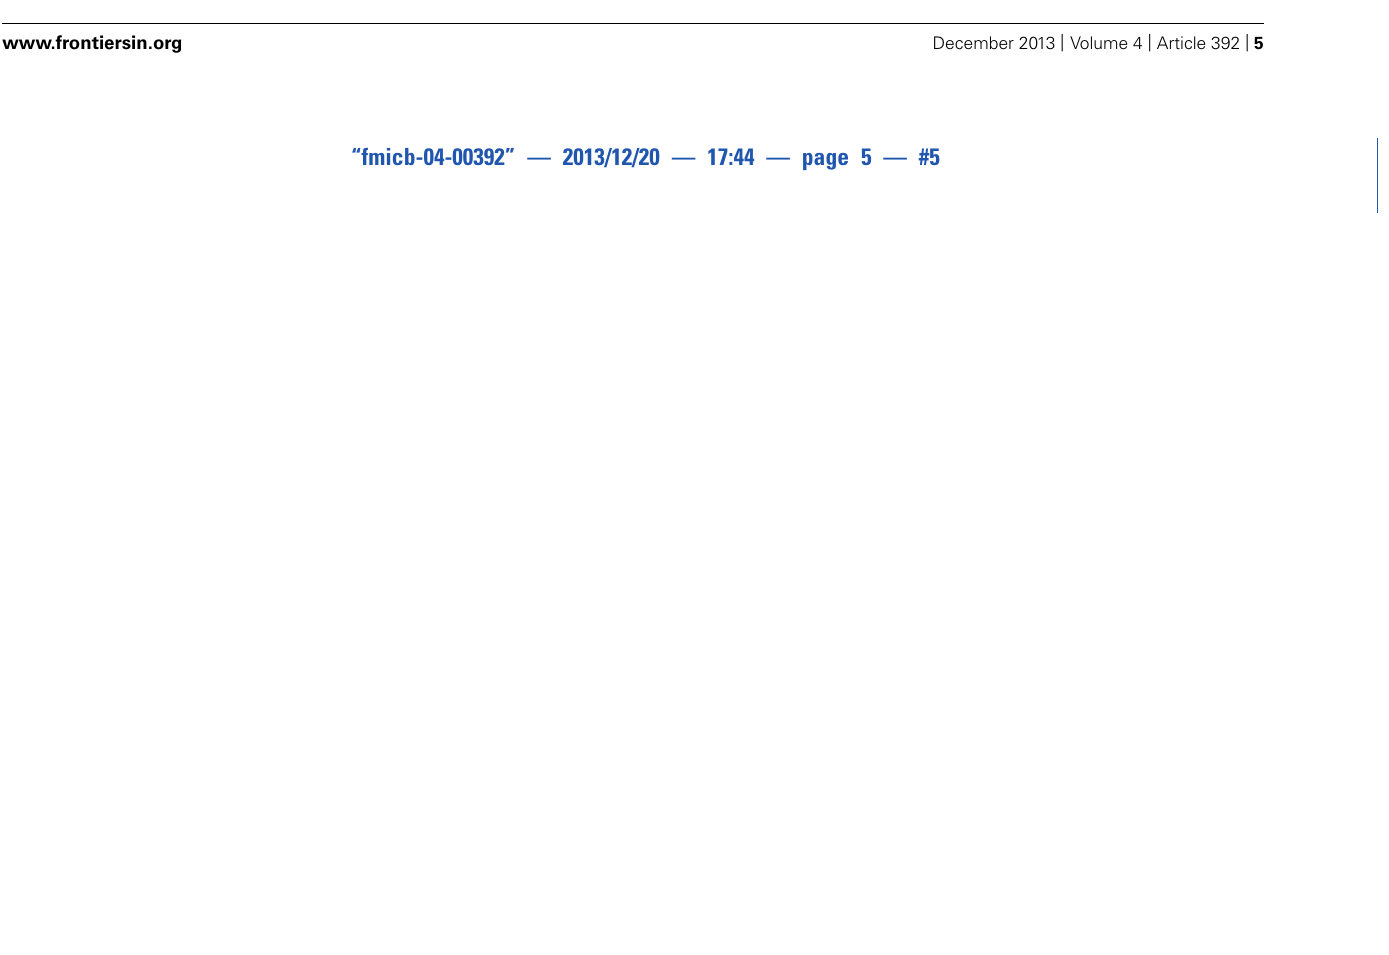
CXA-202 is the combination of ceftolozane (CXA-201) with tazobactam ( Figure 5 ). This formulation is targeted for P. aeruginosa and other MDR strains and has advanced into Phase 3 trials. Per se , this is not a novel β -lactamase inhibitor but is a new partner. The enhanced activity of the cephalosporin partner will be examined closely as this combination represents a novel testing paradigm in this